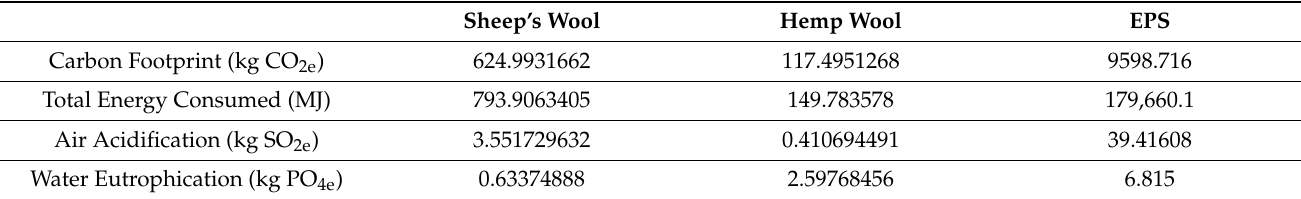
Table 6. Total Carbon Footprint, Total Energy Consumed, Air Acidification and Water Eutrophication for production (extraction and manufacturing), transport, end of life for expanded polystyrene, sheep’s wool and hemp wool, with a thickness of 10